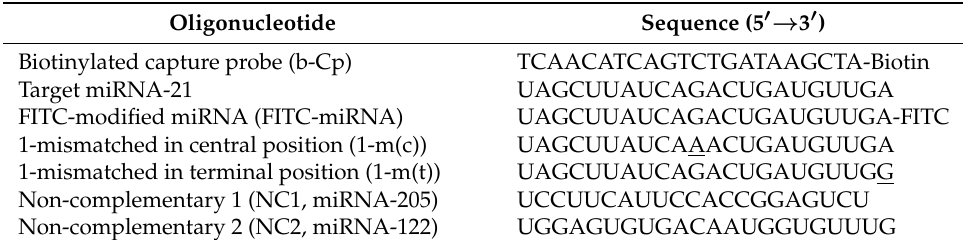
Table 1. Oligonucleotides used in this work.